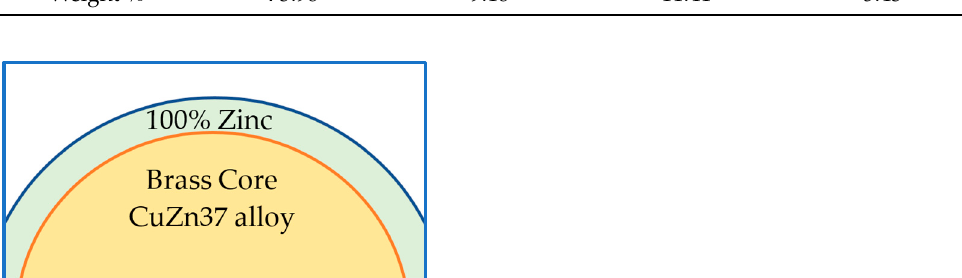
Figure 4 . Relationship between wire vibration amplitude and frequency during ultrasonic vibration - assisted WEDM . Table 1. Element Compositions of Tungsten Carbide. Table 1 . Element Compositions of Tungsten Carbide . Figure 5 . Schematic of zinc - coated brass wire . Table 2 . Brass wire – CuZn37 alloy compositions .